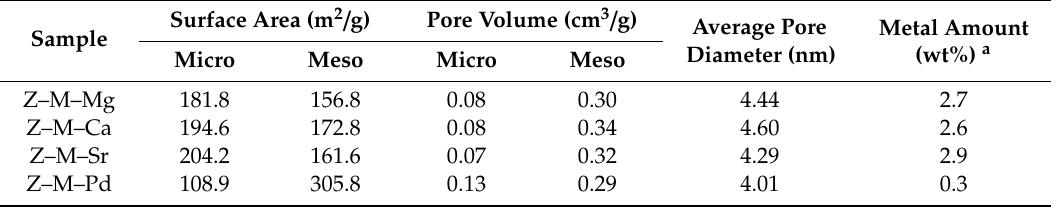
Table 5. The physical properties of the di ff erent